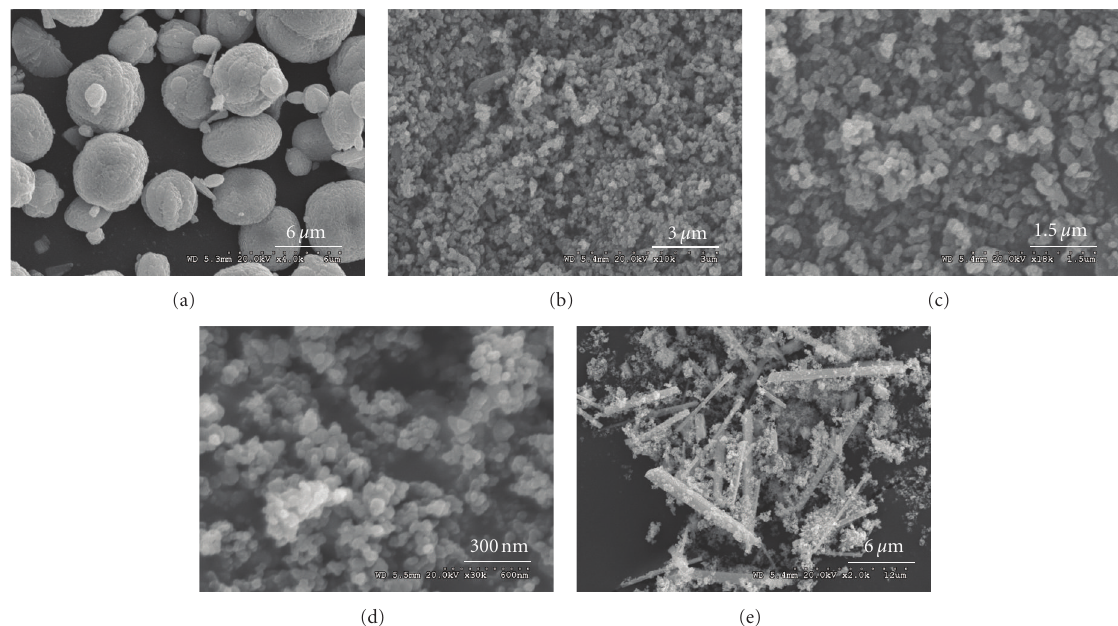
Figure 3: SEM images of BiVO 4 under di ff erent pH at 110 ◦ C. (a) pH = 1.0, (b) pH = 3.0, (c) pH = 5.0, (d) pH = 7.0, (e) pH = 10.0.